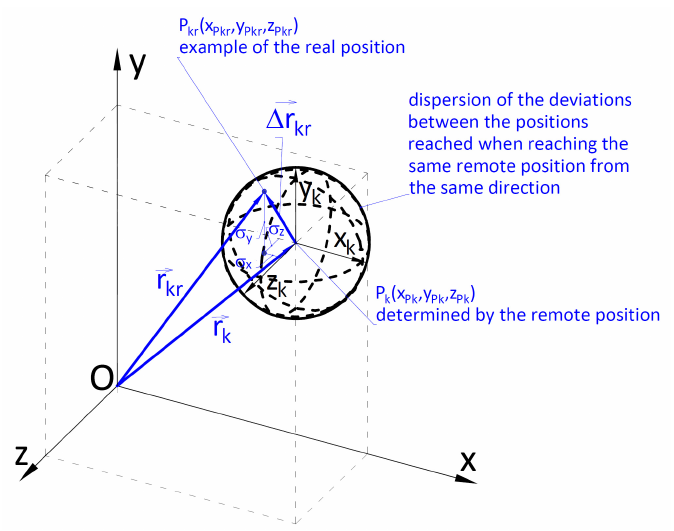
Figure 7. Accuracy of positioning the cargo handling crane when transporting the cargo from the initial position P p to the set target position P k